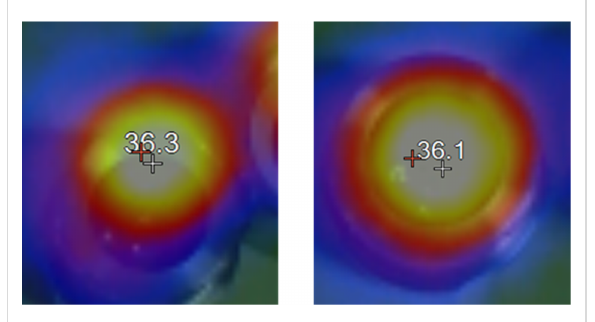
Figure 1: IR thermometer images showing reactor temperatures at the end of the two individual ball-milling reactions (averaged results collected in Table 1, entry 11; individual results, see Supporting Infor- mation File 1, left: Table S1, entry 11-1, right: Table S1, entry